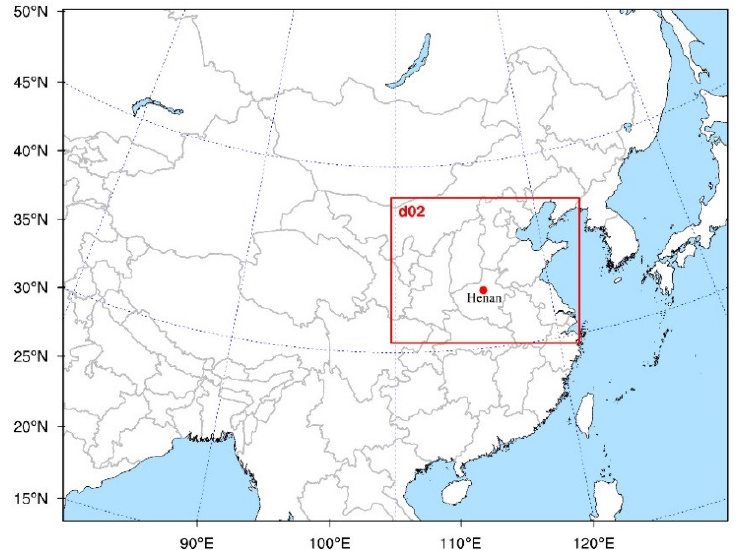
Figure 1. Two nested domain settings in the experiments. The outside box is for the outer domain with a resolution of 9 km and the red box is for the inner domain with a resolution of 3 km. The red point (34.6°N, 113.6°E) indicates the capital of Henan province, which was the center of the 7.20 extreme rainstorm.